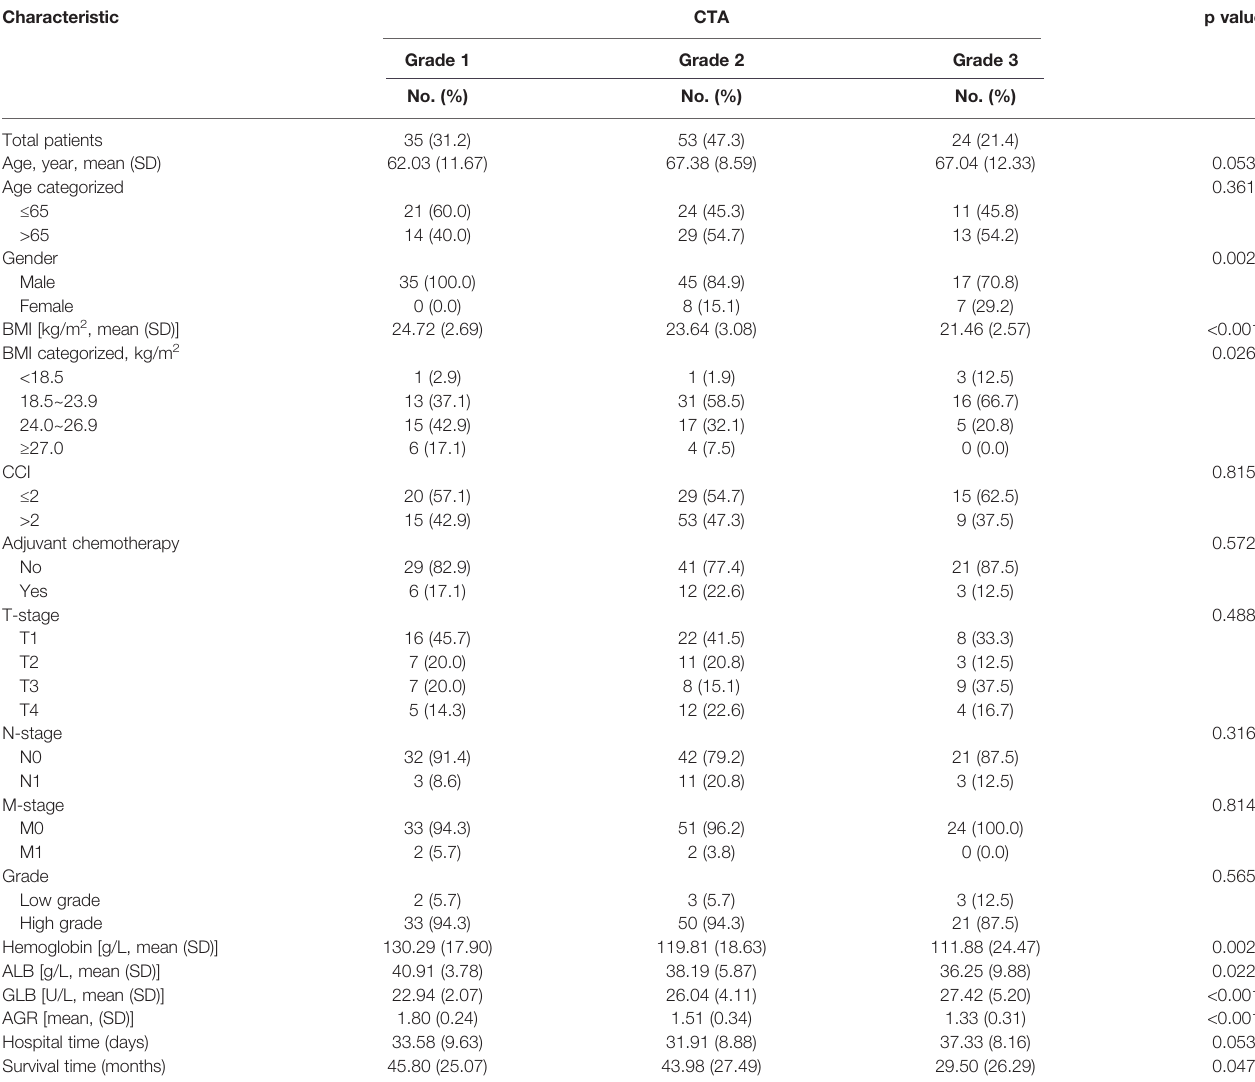
TABLE 3 | Baseline characteristics according to the subgroups classi fi ed by CTA.